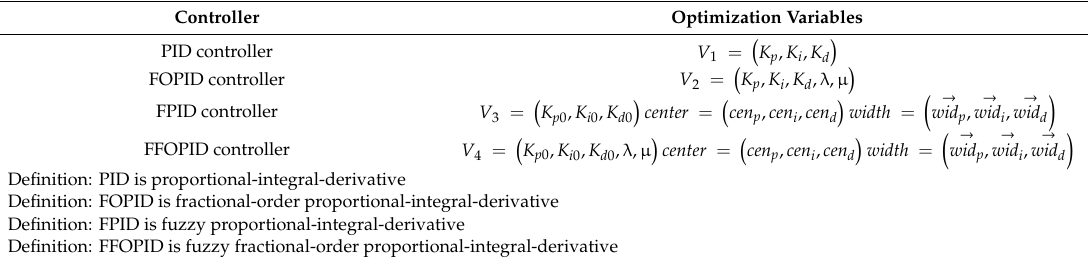
Table 4. Optimization variables of di ff erent controllers.